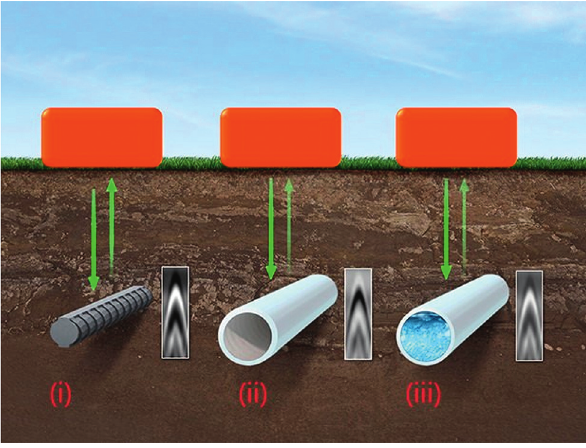
Figure 1: GPR signal for different types of material